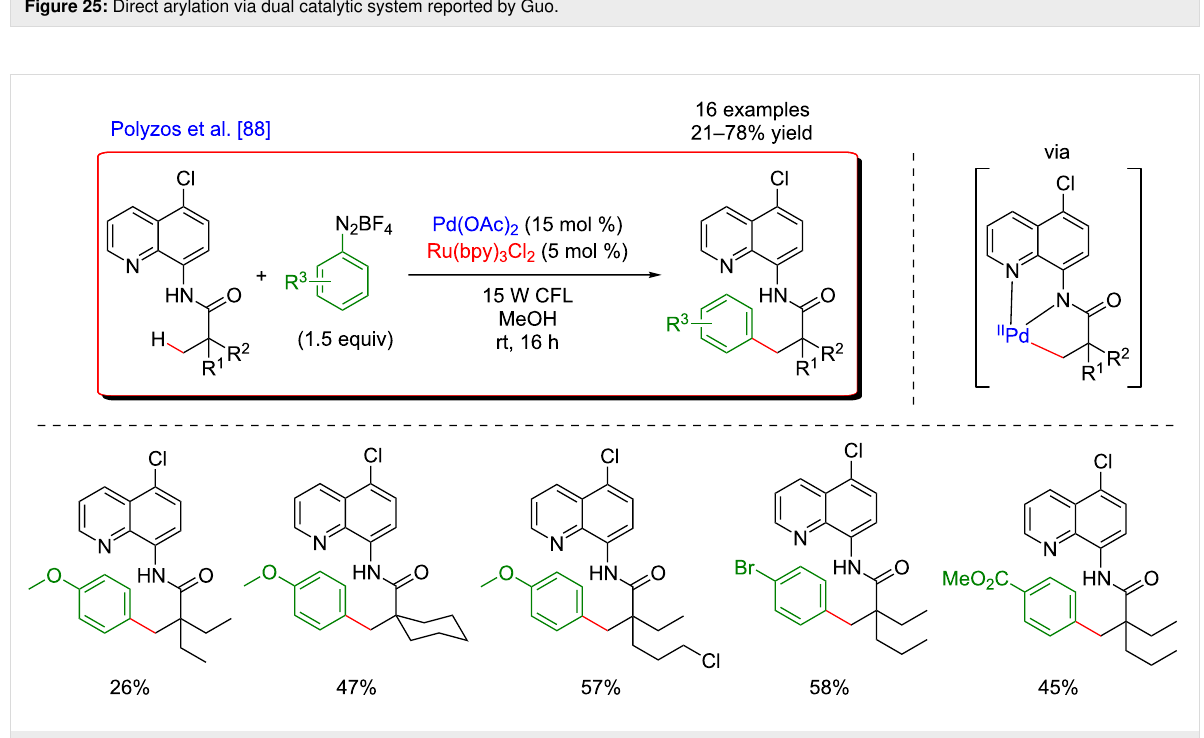
Figure 26: C(sp 3 )–H bond arylation via the dual Pd/photoredox catalytic system.